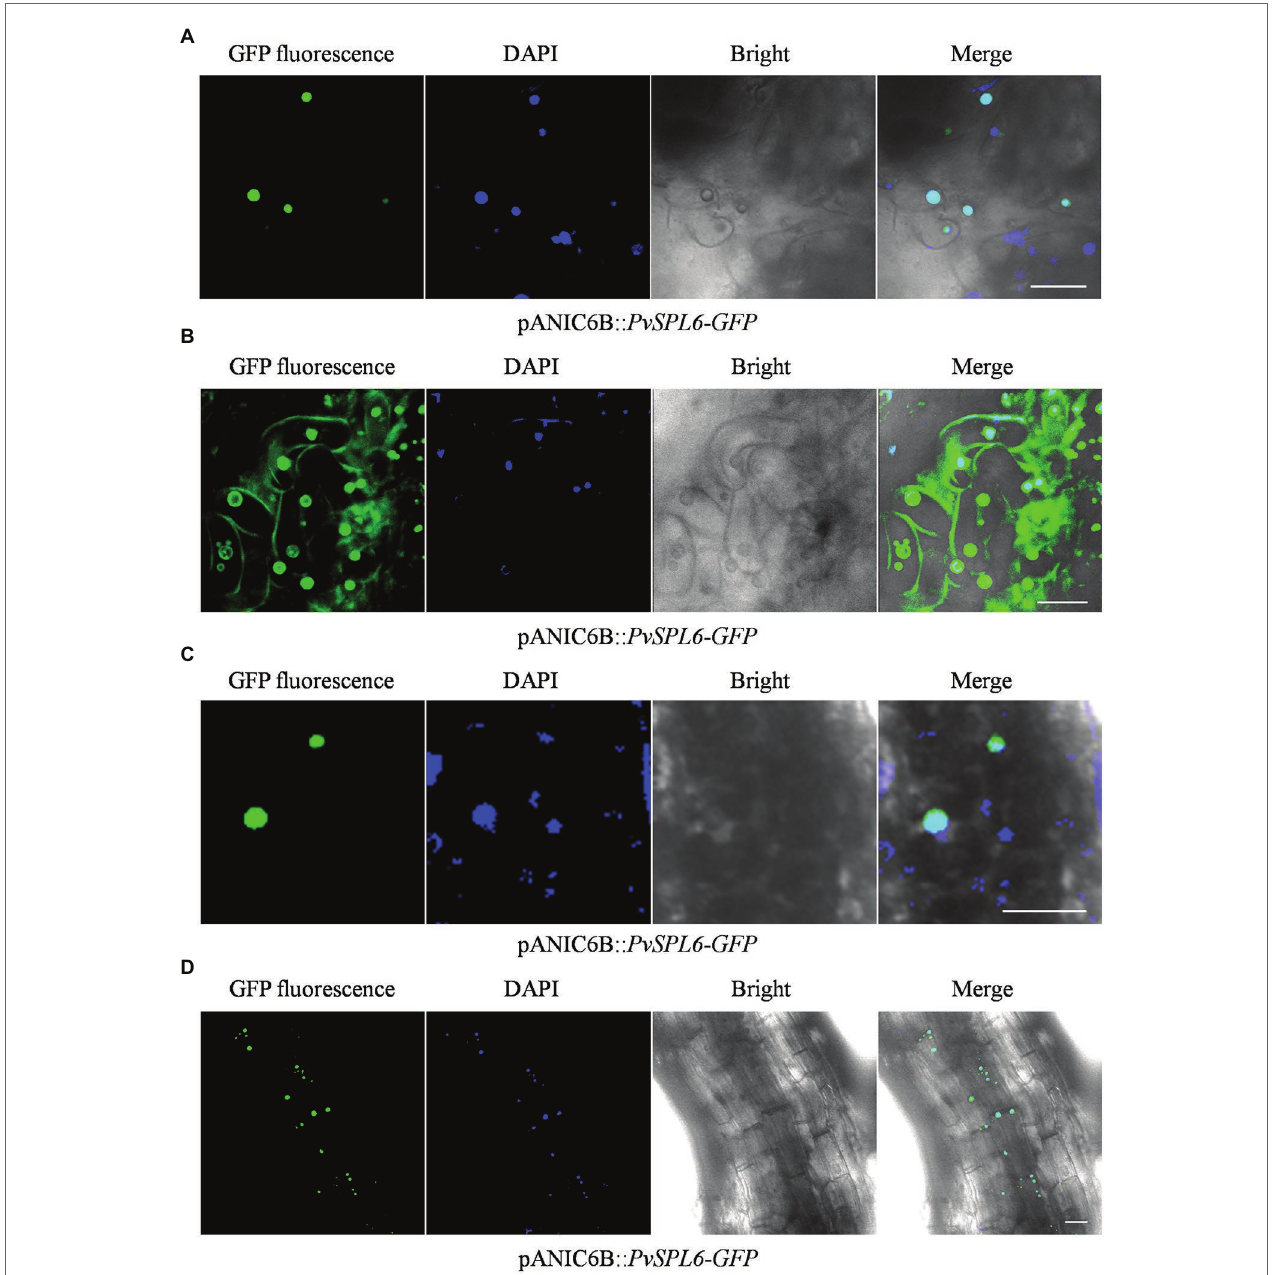
FIGURE 6 | Subcellular localization analysis of different tissues in PvSPL6-GFP OE transgenic plants. (A) Subcellular localization analysis of undifferentiated embryogenic callus of PvSPL6-GFP OE transgenic plants. (B) Subcellular localization analysis of differentiated embryogenic callus of PvSPL6-GFP OE transgenic plants. (C) Subcellular localization analysis of leaves from PvSPL6-GFP OE transgenic plants. (D) Subcellular localization analysis of roots from PvSPL6-GFP OE transgenic plants. GFP fluorescence, green fluorescent signal; DAPI, 4 ′ ,6-diamidino-2-phenylindole signal; Bright, bright field signal; and Merge, superimposed signal. Scale bar = 20 μ